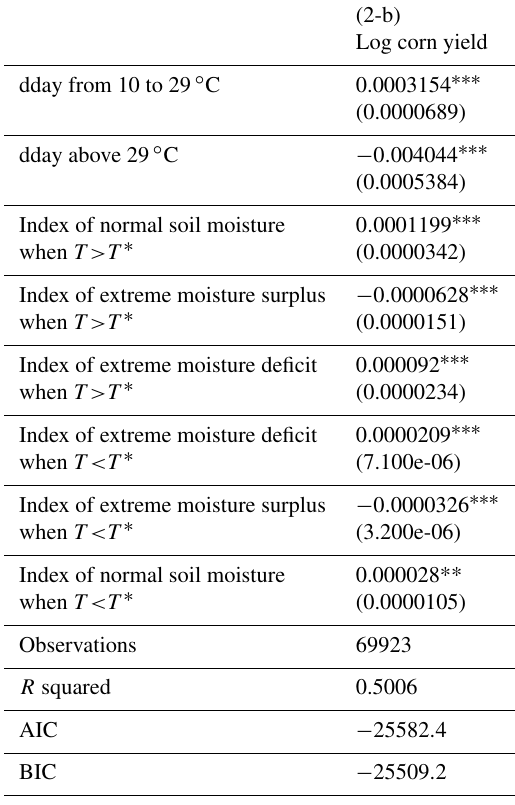
Table 4. Estimation of corn yields while splitting the soil moisture metrics in Model